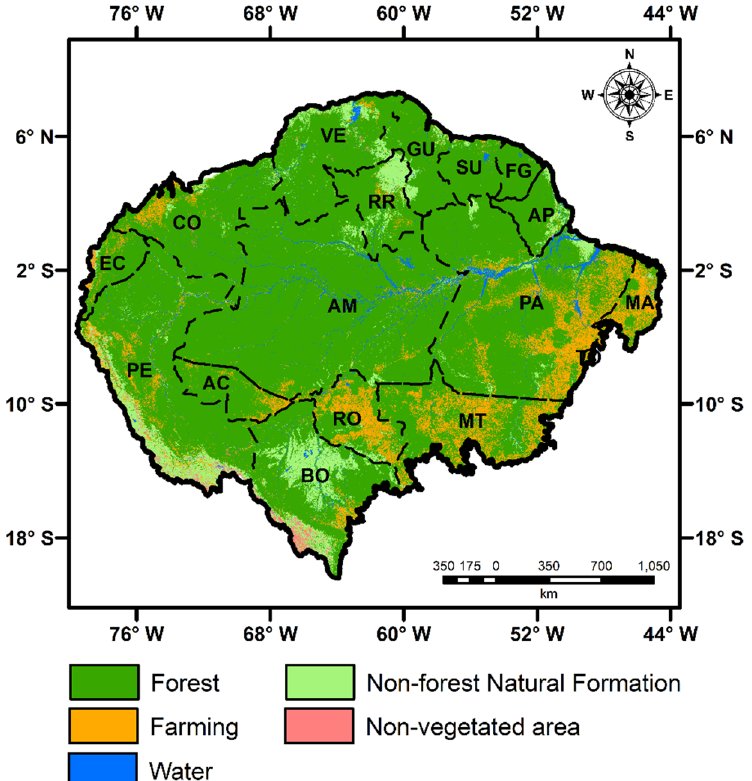
Figure 6. Spatial distribution of Land Use and Land Cover categorized by the MapBiomas Amazonia dataset Collection 2.0 in Amazonia for the year 2018. BO = Bolivia, CO = Colombia, EC = Ecuador, FG = French Guiana, GU = Guiana, PE = Peru, SU = Suriname, VE = Venezuela, AC = Acre, AM = Amazonas, AP = Amapá, MA = Maranhão, MT = Mato Grosso, RO = Rondônia, RR = Roraima, PA = Pará and TO = Tocantins.